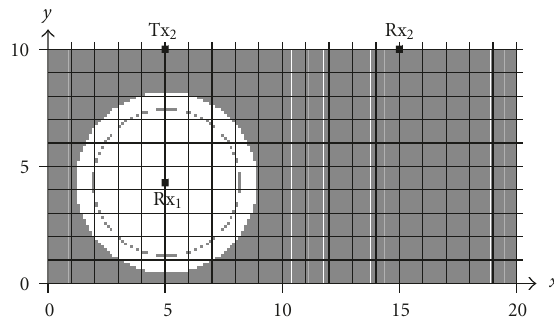
Figure 6: I (1,3) : verification of Property 1 for transmitter 1 with ( Δ a , Δ b ) = (0 . 125m,0 . 125m).